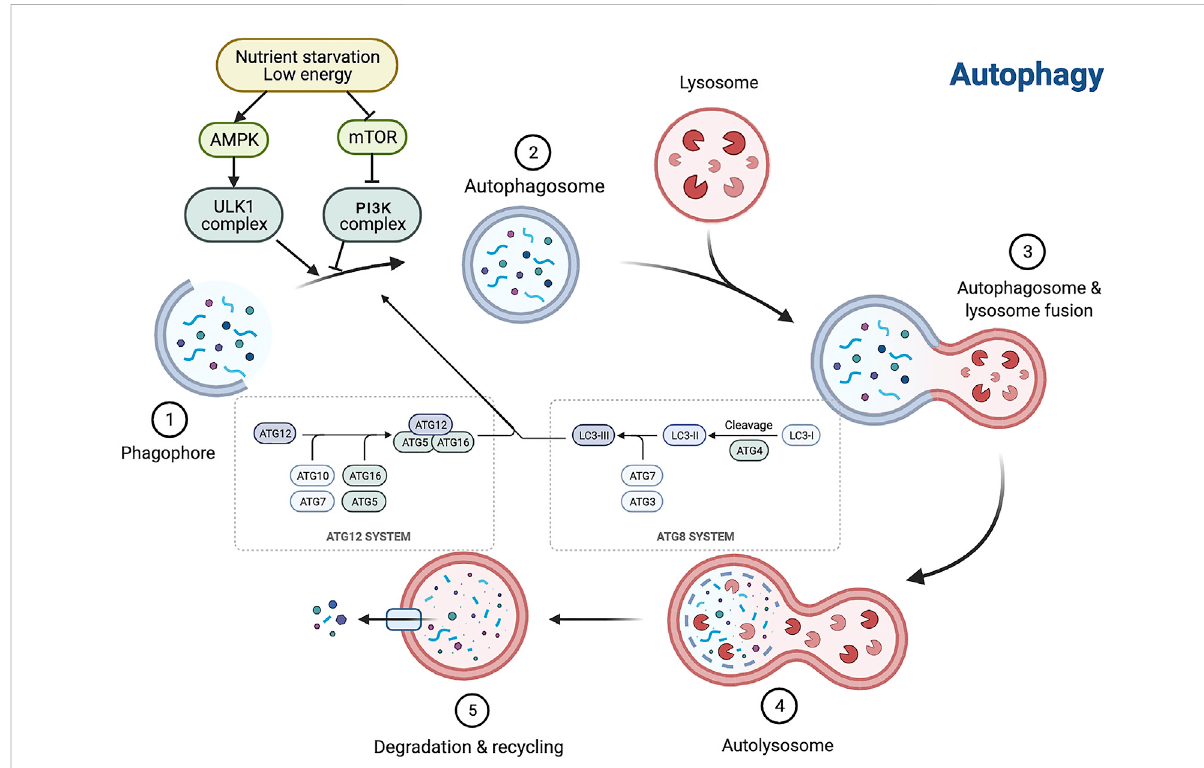
FIGURE 1 Autophagyisinterferedwithabroadvarietyoffactors,andtheautophagyprocessconsistsofaseriesofcellularevents.Autophagyisamultistep process involving initiation, nucleation, expansion, fusion and degradation. AMPK, AMP-activated protein kinase; mTOR, mammalian target of